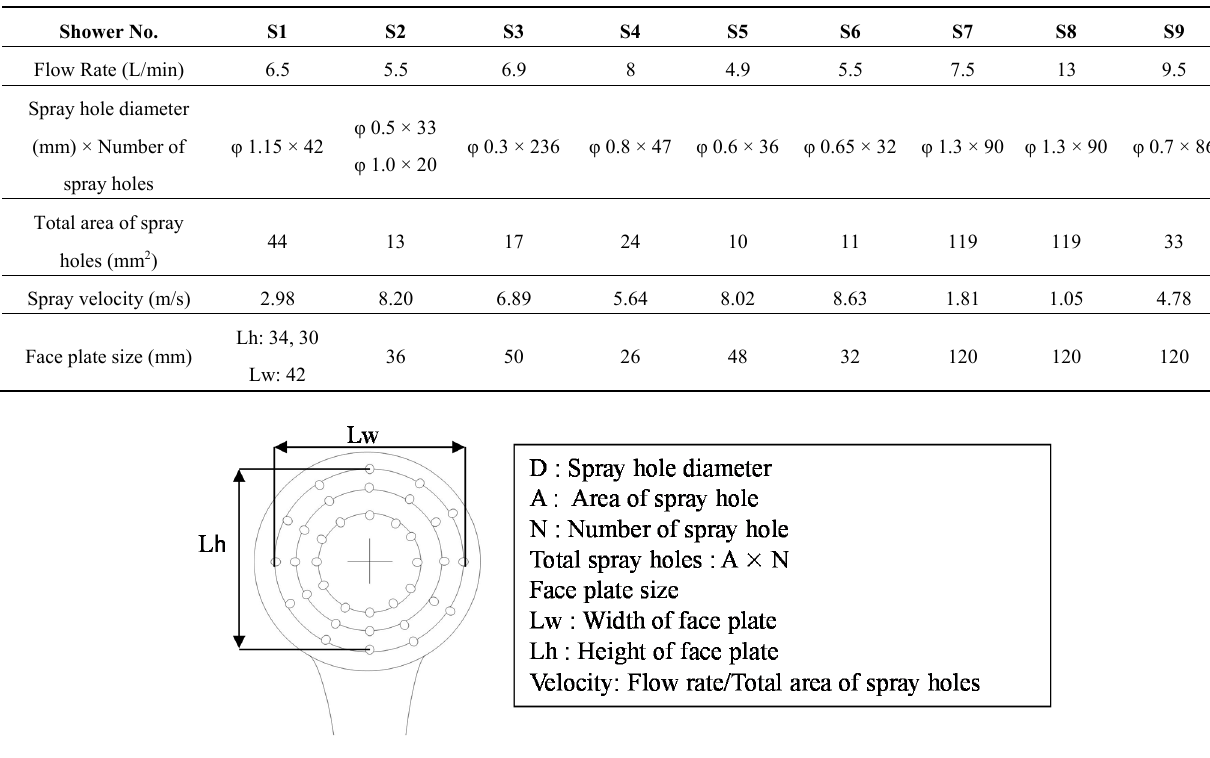
Figure 1. Design parameters of